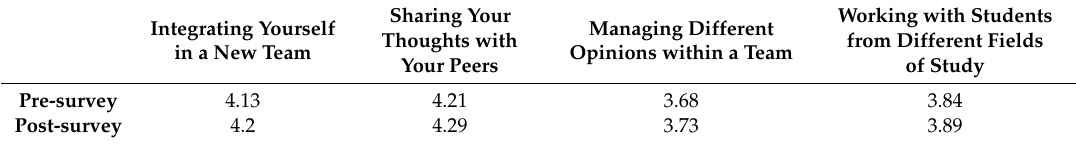
Table 5. Obstacles students may face/had faced during the programme related to